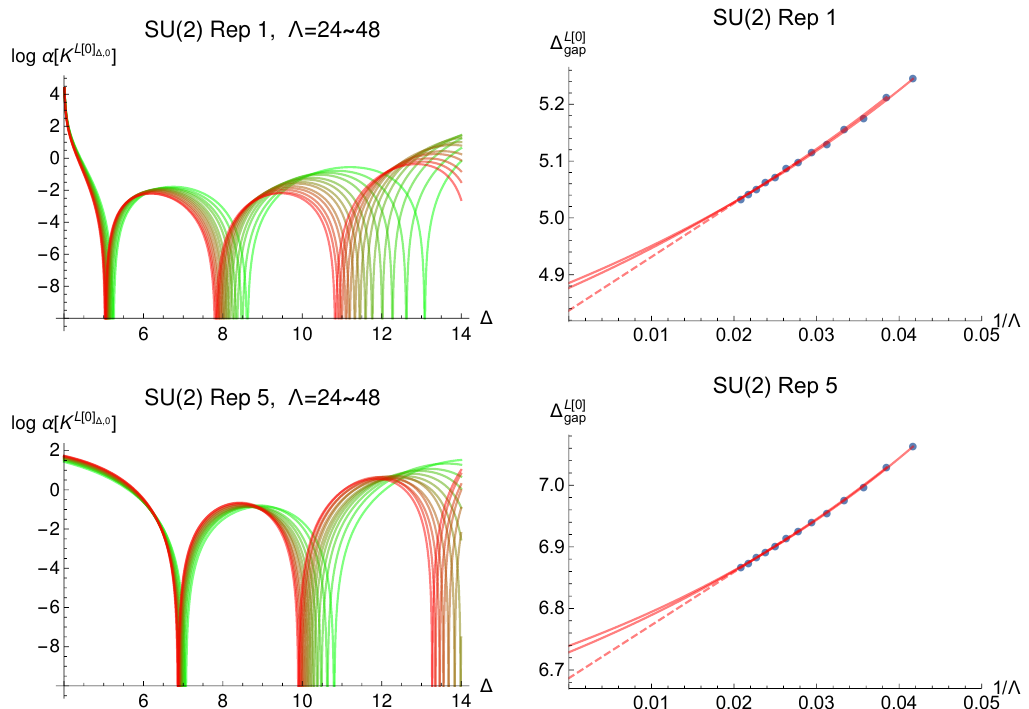
Figure 7. Left: the extremal functional optimizing the lower bound on C J when C T is set to the four-instanton value in the rank-one Seiberg E 1 theory, acted on the contribution of the spin- zero long multiplet to the crossing equation, (cid:11) [ K L [0] (cid:1) ; 0 ], in the 1 and 5 of SU(2), plotted D [2] ; 3 in logarithmic scale. Increasing derivative orders (cid:3) = 24 ; 26 ; : : : ; 48 are shown from green to red. Right: the gaps at di(cid:11)erent (cid:3), and extrapolations to (cid:3) ! 1 using the exponential ansatz (5.23) for (cid:3) 2 4 Z and (cid:3) 2 4 Z + 2, separately (solid), and using the linear ansatz (5.23) (dashed).